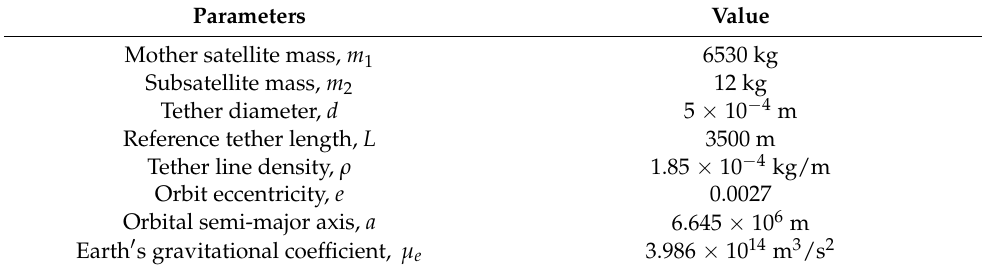
Table 2. TSS parameter values.